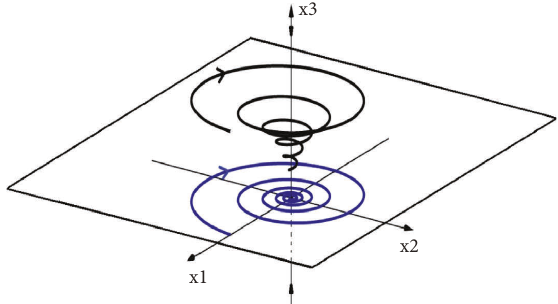
Figure 2: Qualitative behavior of the solutions when 0 < β < 1/ h